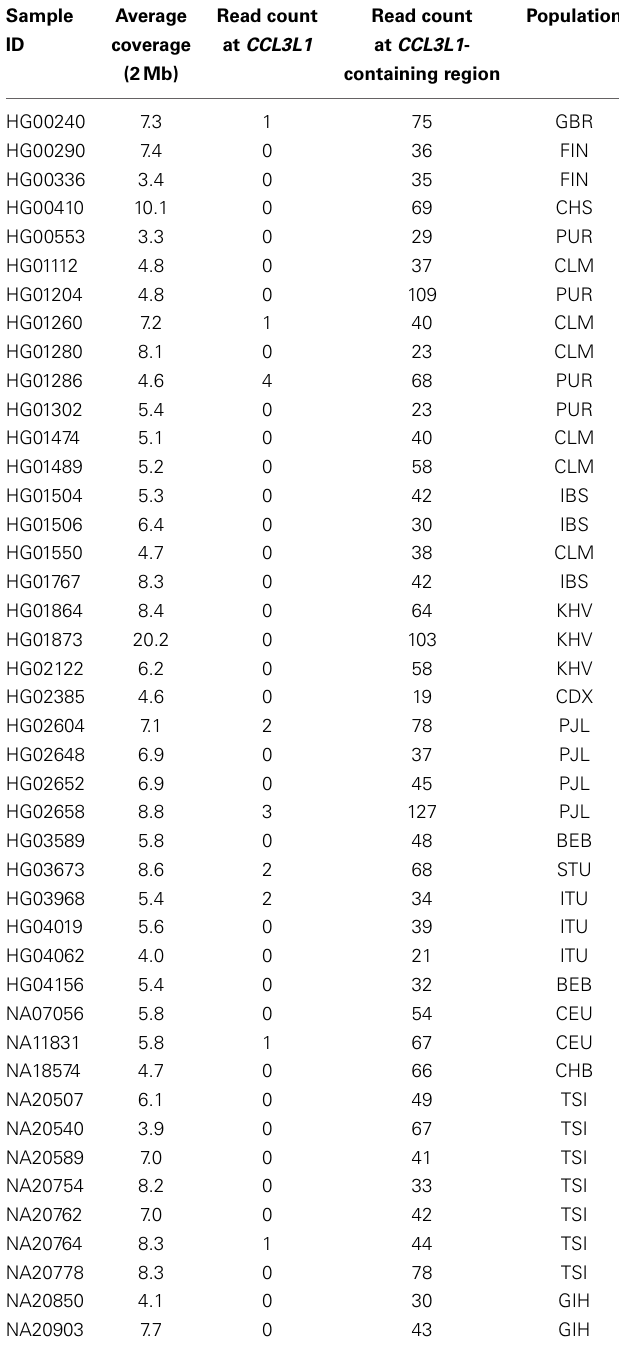
Table 4 | Read counts at the CCL3L1 gene (chr17:34623842-34625730) (1.9kb) of samples called 0 copies by CNVrd2.